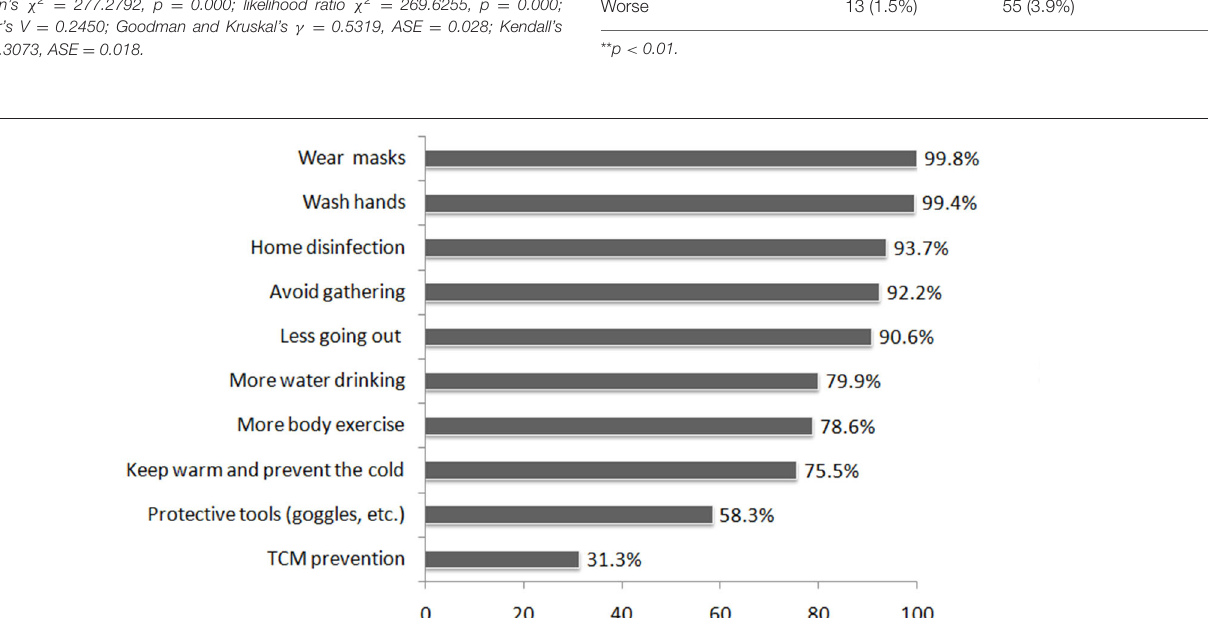
Frontiers in Public Health |